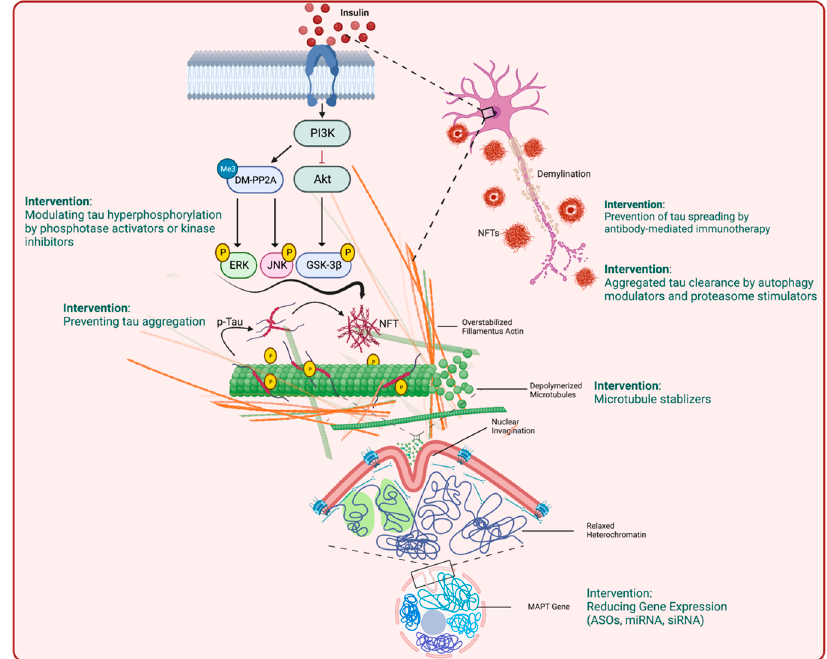
Figure 6. Tau-related therapeutic interventions (created with BioRender.com). Clinical trials and preclinical studies on tauopathies mainly focus on various aspects of pathogenic tau and its consequences, including modulating tau hyperphosphorylation and inhibiting other PTMs such as O-deglycosylation, preventing tau aggregation or stimulating tau clearance by autophagy modulators or proteasomal degradation, active or passive immunotherapies, applying microtubule stabilizers and reducing MAPT gene expression levels.